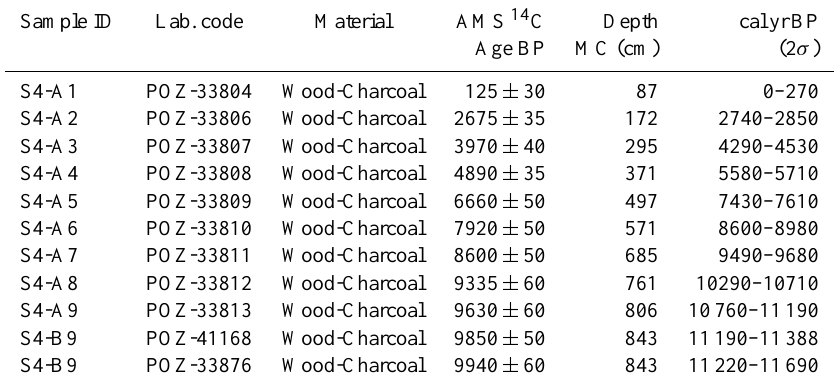
Table 1. AMS-radiocarbon dates with 2 σ range of calibration from Lago Trifoglietti’s S2A and S2B cores. Sample